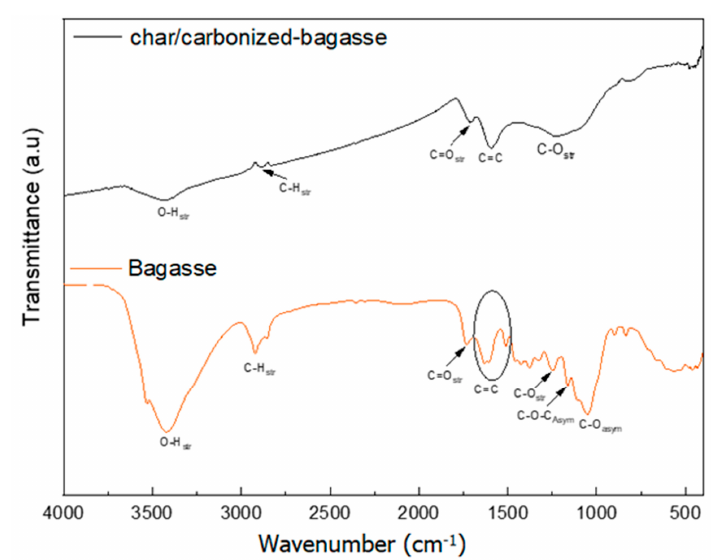
Figure 4. FTIR of the bagasse and the carbonized bagasse. Table 1. Peaks of vibration detected by FTIR analysis to the carbonized bagasse.